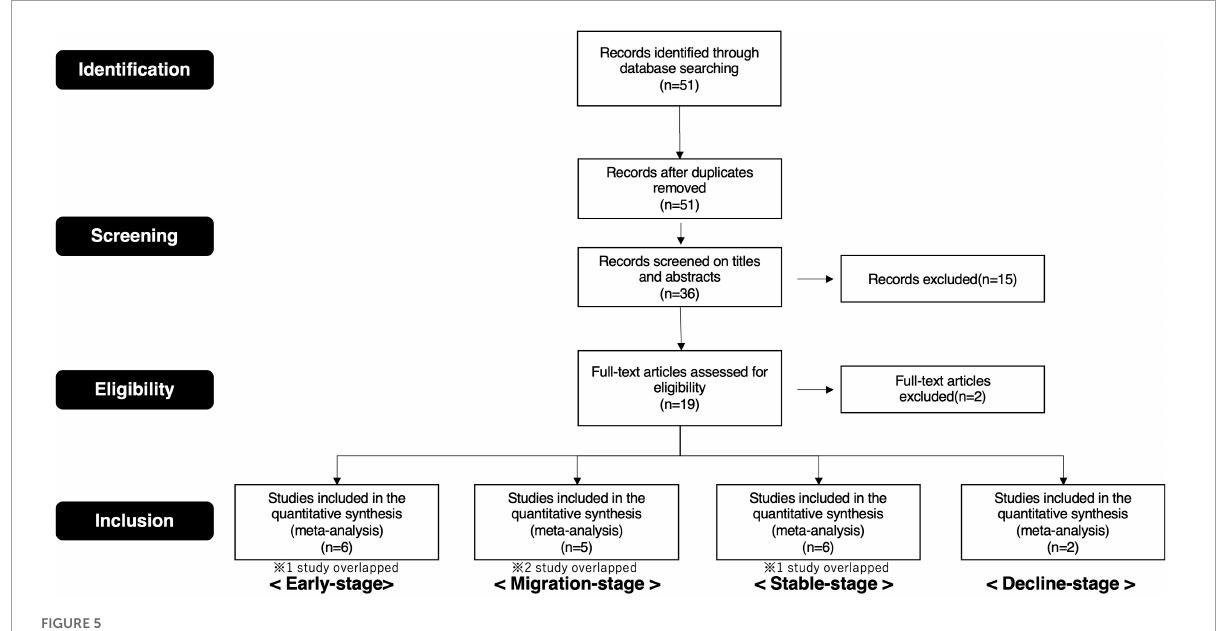
FIGURE5 PRISMA flow diagram (interpersonal romantic love